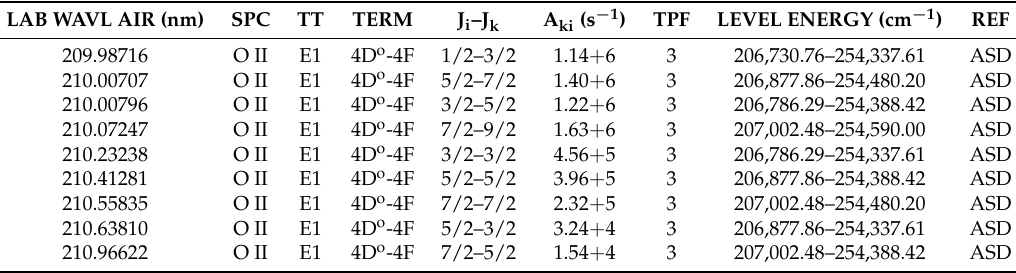
Table 2. Sample output from a multiplet query obtained by clicking on the first term field shown in Table 1. The columns and entries have the same meaning as in Table